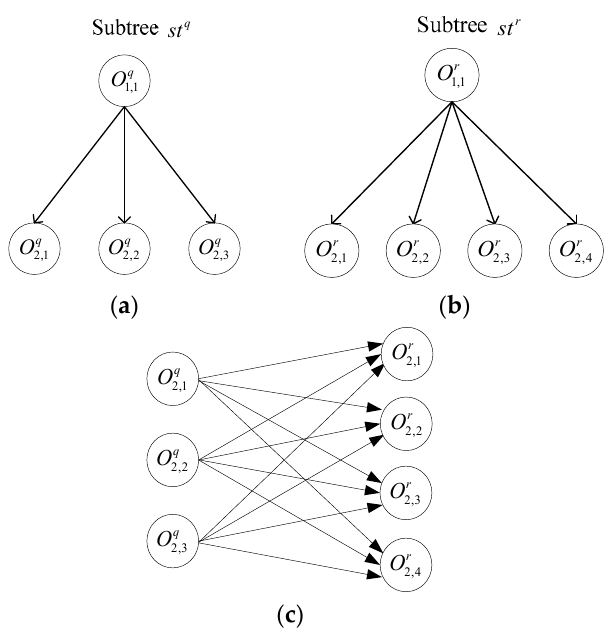
Figure 7. An unmatched problem between two subtrees. ( a ) child nodes, n = 3; ( b ) child nodes, m = 4; ( c ) unmatched problem.